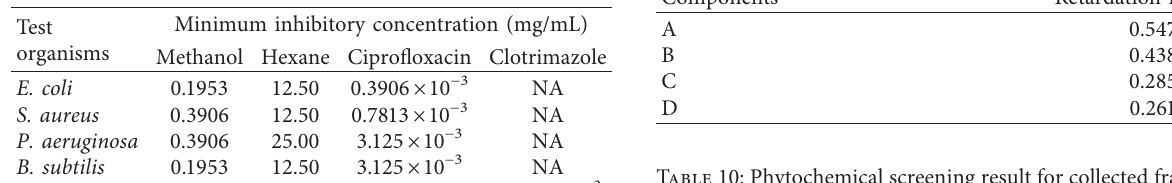
NA: not applicable; diameter of the cork borer � 10mm. Table 7: Minimum inhibitory concentrations (MICs) of the ex- tracts of V. camporum and reference standard drugs against test organisms.